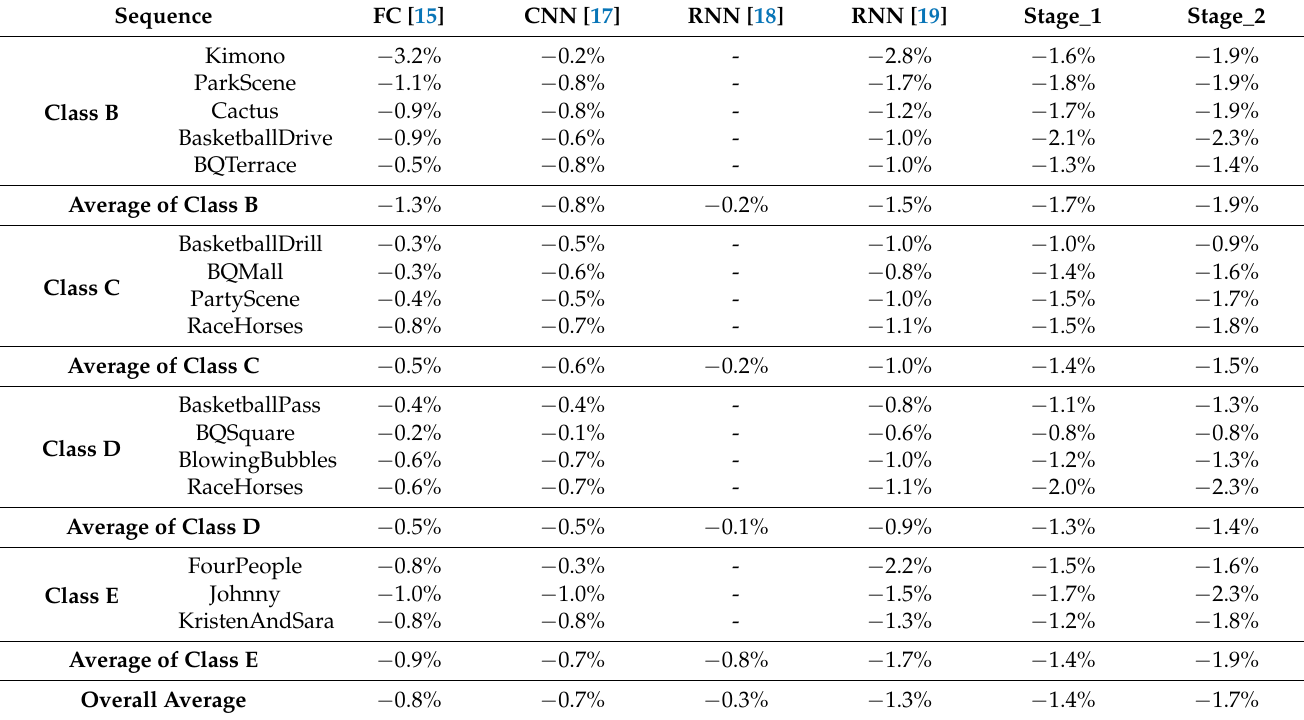
Table 5. Coding efficiency comparison with previous works.